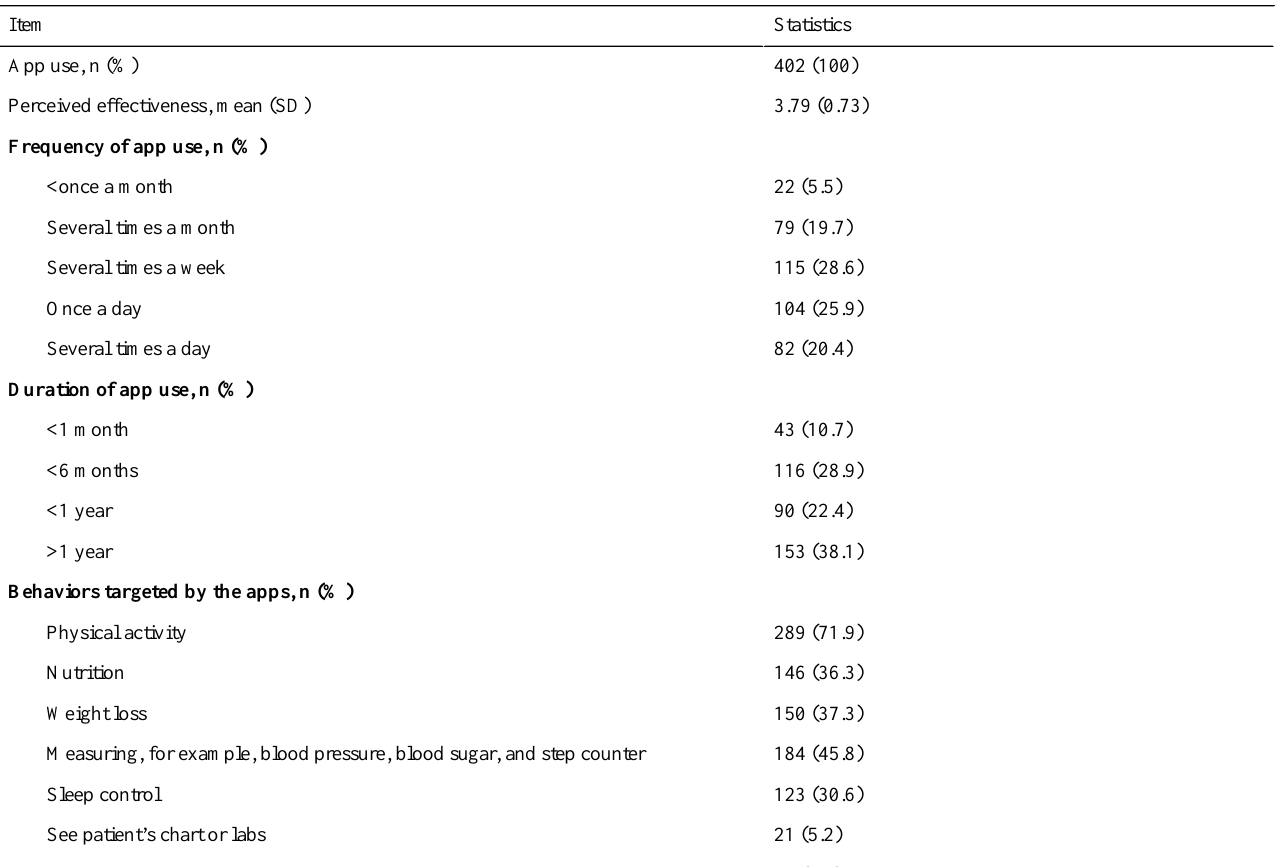
Table 2. Characteristics of health apps and health app